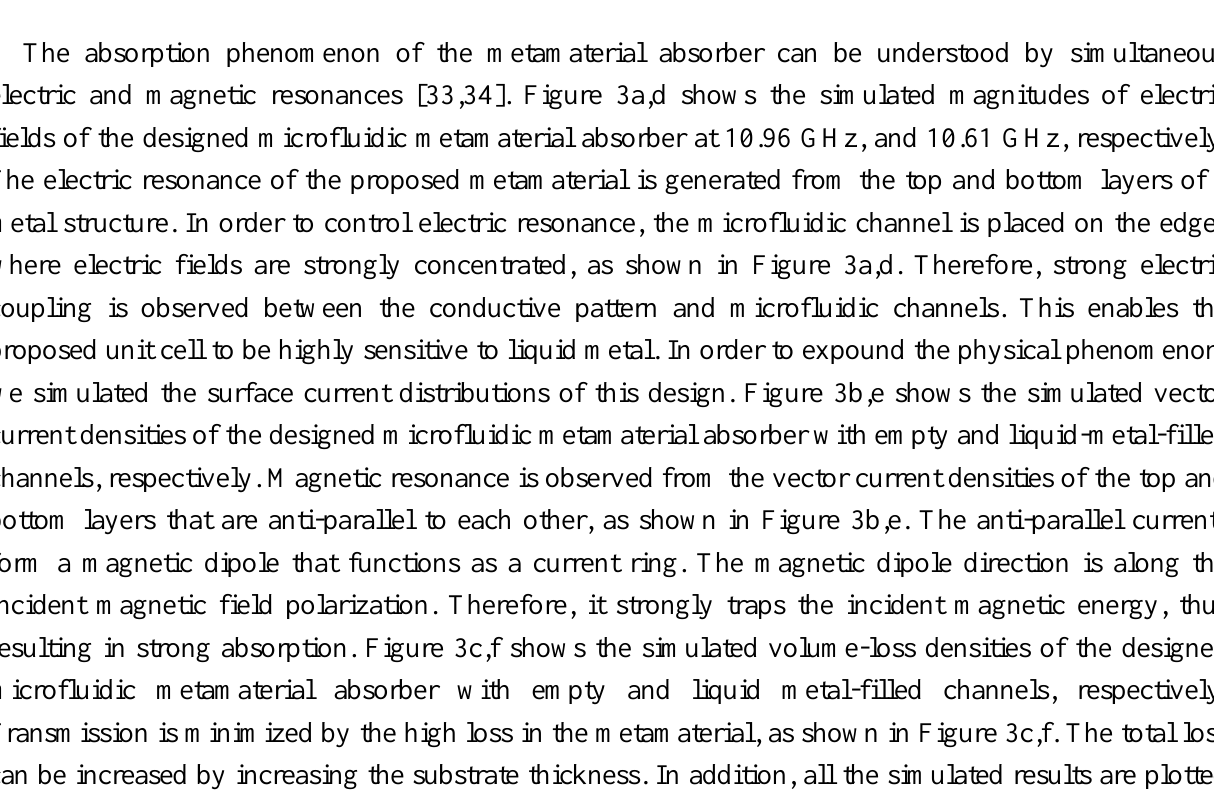
Figure 2. Illustration of the proposed microfluidic metamaterial absorber with the rectangular waveguides: a = 64 mm, b = 16 mm, c = 53 mm, x = 41.5 mm, y = 41.5 mm, L = 22.92 mm, w = 10.22